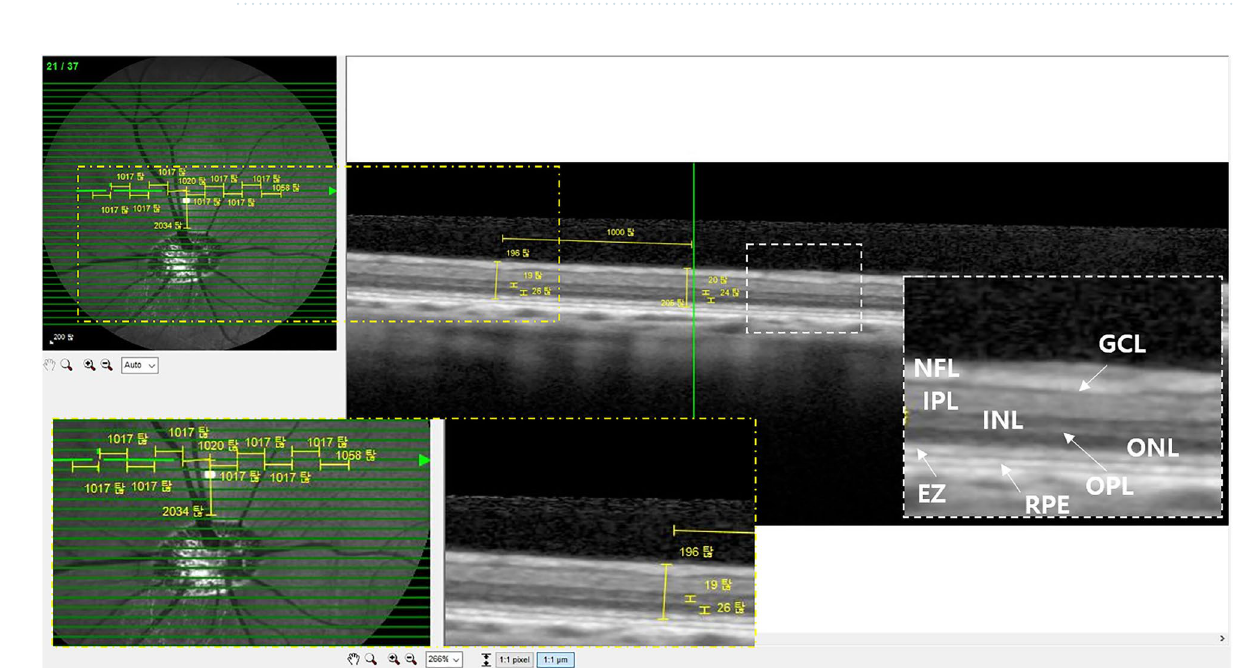
Figure 10. Measurement of total retinal thickness, inner nuclear layer thickness, and outer retinal thickness. Total retinal thickness, inner nuclear layer thickness, and outer retinal thickness were measured at 10 points with 1 mm intervals on the visual streak. Magnified SD-OCT images are shown with a white or yellow dashed- line box. Magnified SD-OCT images in yellow dashed-line boxes show estimated total retina thickness, inner nuclear thickness, and outer retinal thickness. Magnified SD-OCT images in white dashed-line boxes show NFL, GCL, IPL, INL, OPL, EZ, and PRE. NFL nerve fiber layer, GCL ganglion cell layer, IPL inner plexiform layer, INL inner nuclear layer, OPL outer plexiform layer, EZ ellipsoid zone, RPE retinal pigment